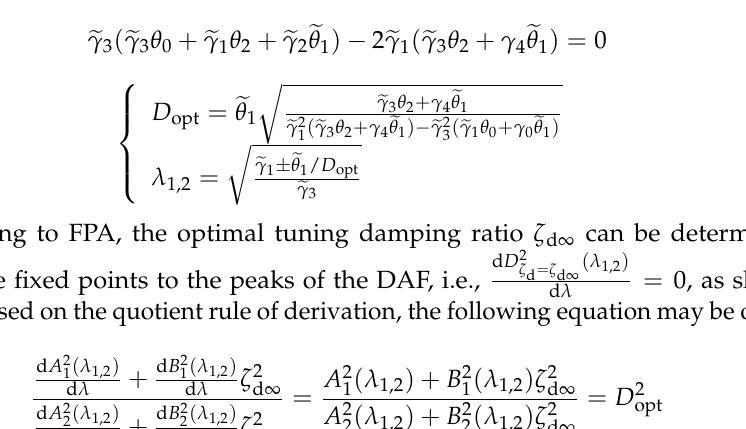
Figure 2. The DAF curves D ( λ ) with different ν and ζ d . ( a ) D ( λ ) with different ν ; the fixed points are equal when ν = ν ∞ . ( b ) D ( λ ) at ν ∞ with different ζ d ; the fixed points are approximately assigned to the equal peaks when ζ d = ζ d ∞ . By substituting Equation (9) into Equation (10), ν ∞ can be obtained by solving Equation (11) analytically. The coordinates of the optimal fixed points ( λ 1, 2 , D opt ) are given by Equation (12).